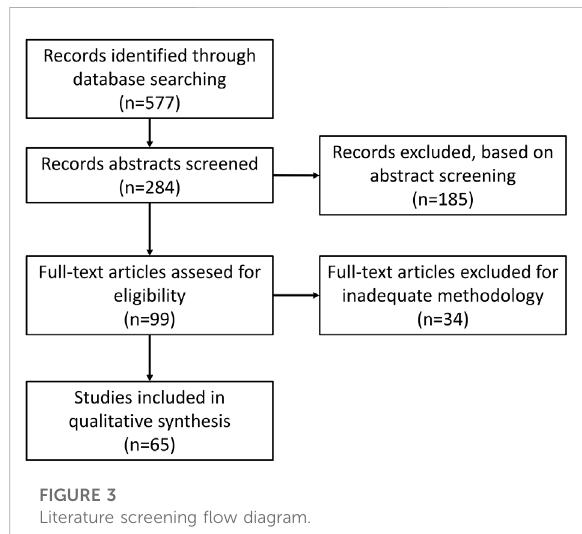
FIGURE 3 Literature screening fl ow